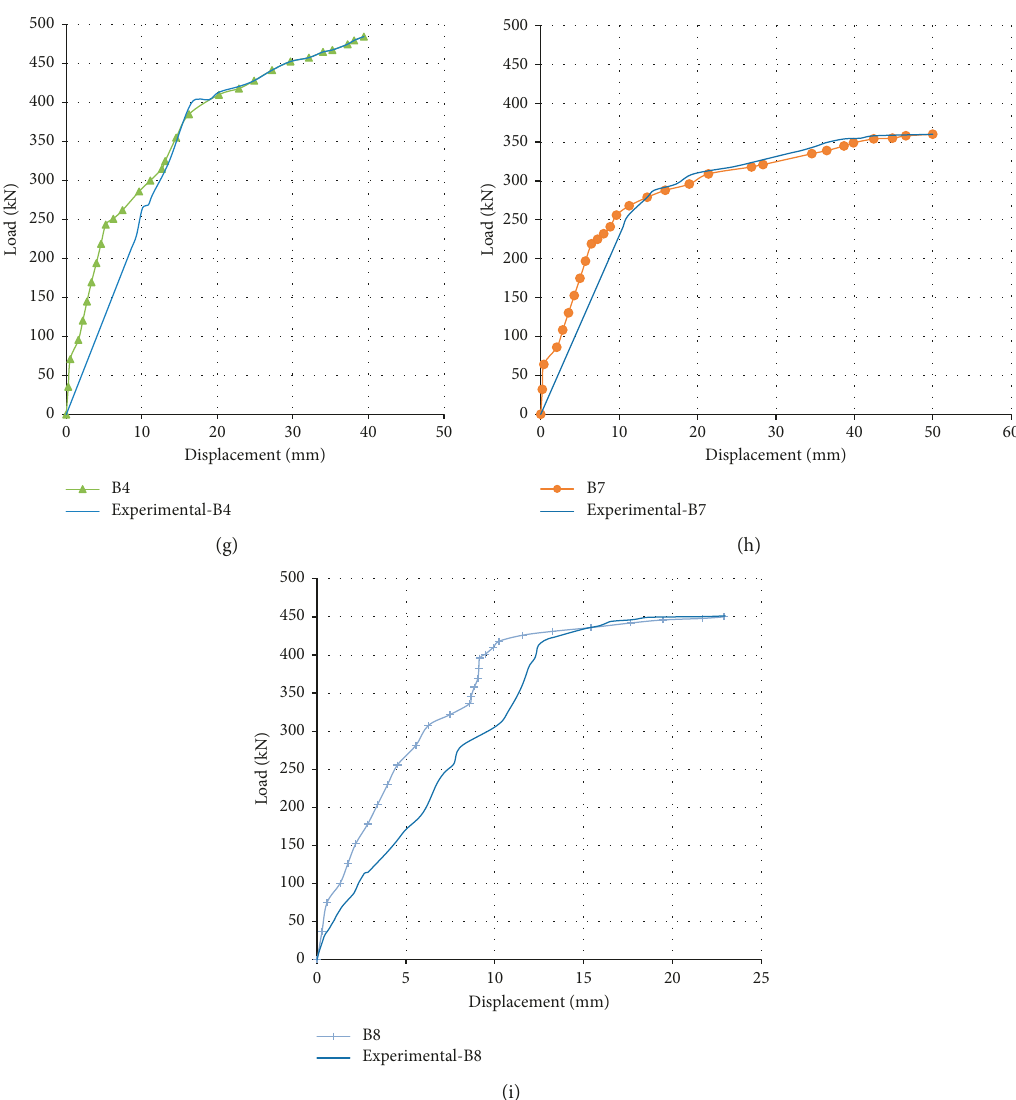
Figure 8: (a) Load-deflection performances at the midspan for all models. Deflection comparisons between experimental and numeri- cal analysis at the (b) yield stage and (c) maximum stage. Load-deflection compression for models (d) B1, (e) B2, (f) B3, (g) B4, (h) B7, and (i) B8. Table 5: Statistical comparison of experimental and current FE approach (the yield and maximum deflections).